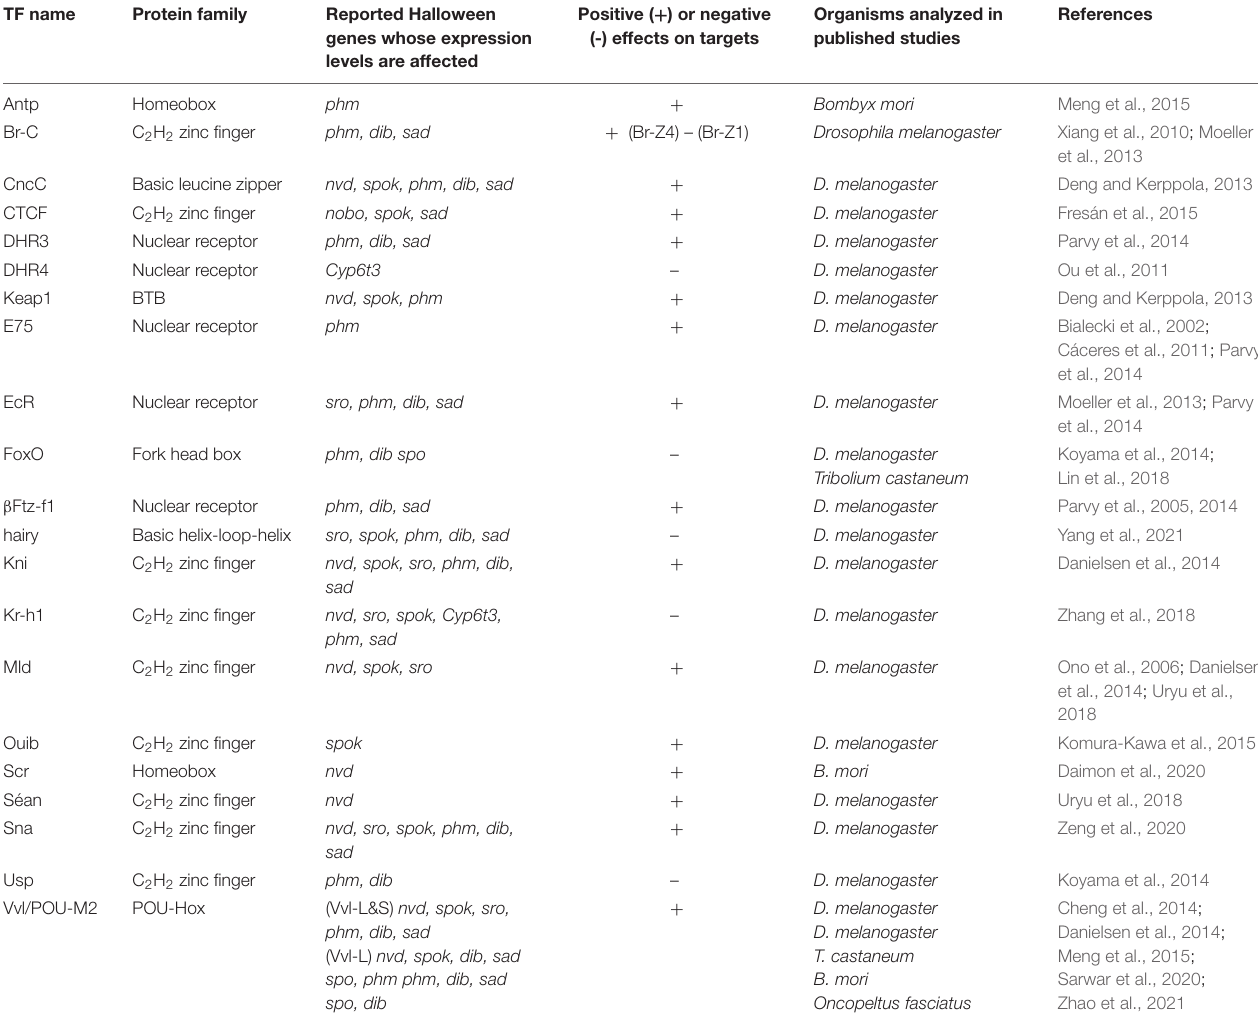
TABLE 2 | A list of ecdysteroidogenic transcription